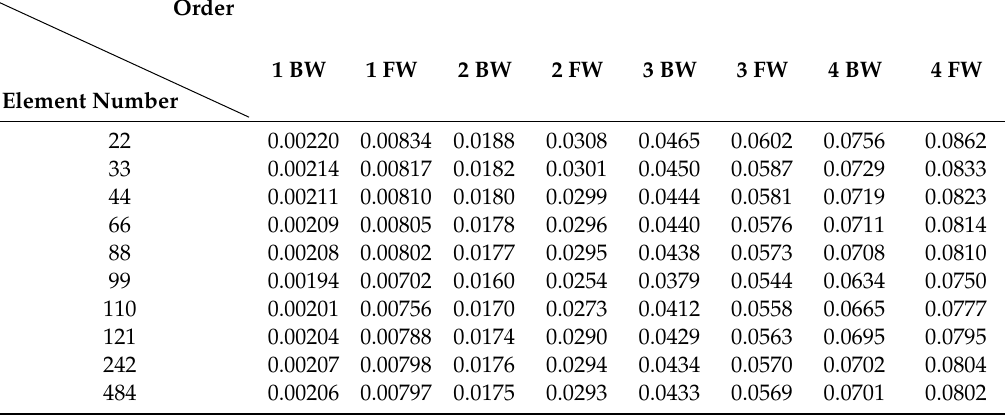
Table 16. Natural frequencies via spatial discretization ( h = 2000